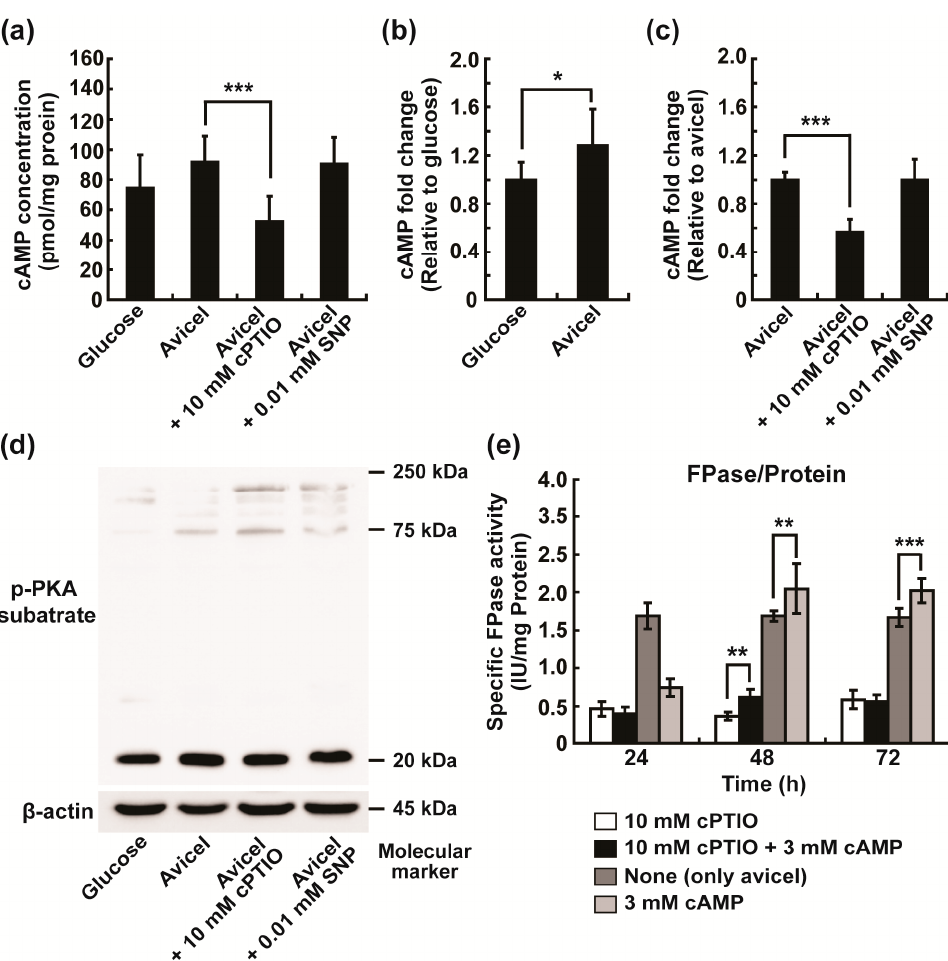
Figure 7. Analysis of the relationship between intracellular NO and cAMP signaling. ( a – c ) Measurement of intracellular cAMP concentration; cAMP concentration in fungal hyphae grown in glucose or Avicel medium for 4 h and effects of cPTIO and SNP on cAMP concentration ( a ), fold change in cAMP concentration compared to that in glucose medium ( b ), fold change in cAMP concentration compared to that in Avicel medium ( c ). ( d ) Levels of phospho-PKA substrate detected by Western blot to reflect PKA activity. ( e ) Specific activity of cellulolytic enzymes (activity of cellulolytic enzymes per mg of secreted protein) measured in Avicel medium after 24, 48, and 72 h. Each value represents the mean of six or nine replicate measurements (three replicates per experiment and two or three independent experiments): * p < 0.05, ** p < 0.01, *** p < 0.001 as determined by Student’s t -test. cPTIO: 2-4-carboxyphenyl-4,4,5,5-tetramethylimidazoline-1-oxyl-3-oxide; SNP: sodium nitroprusside.